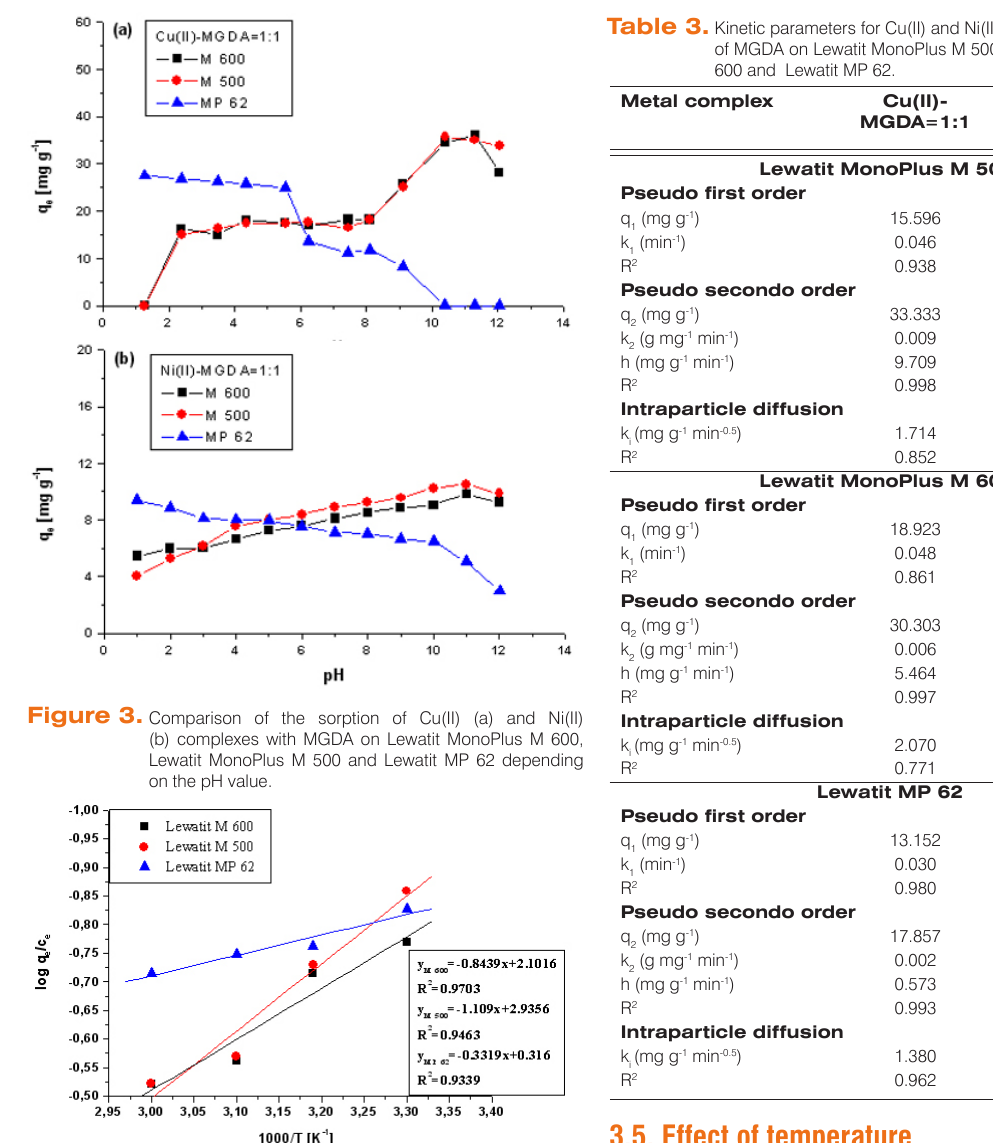
Figure 4. Plots of log qe/ce vs 1/T for estimation of thermodynamic parameters for the sorption Cu(II)-MGDA complexes on Lewatit MonoPlus M 600, Lewatit MonoPlus M 500 and Lewatit MP 62 .